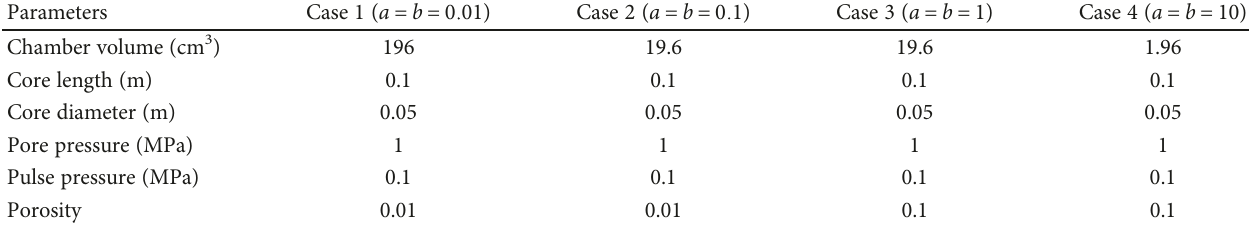
Table 2: Modeling parameters of numerical tests.